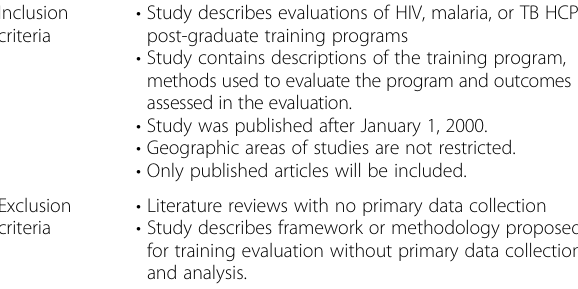
Stage 5: collating, summarizing, and reporting the results